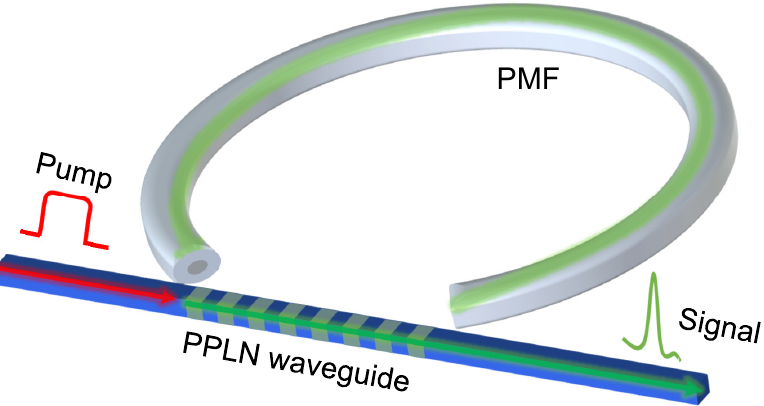
Figure 1. Schematicofthesynchronouslypulse-pumpedOPOwithresonantsignalandnon-resonant